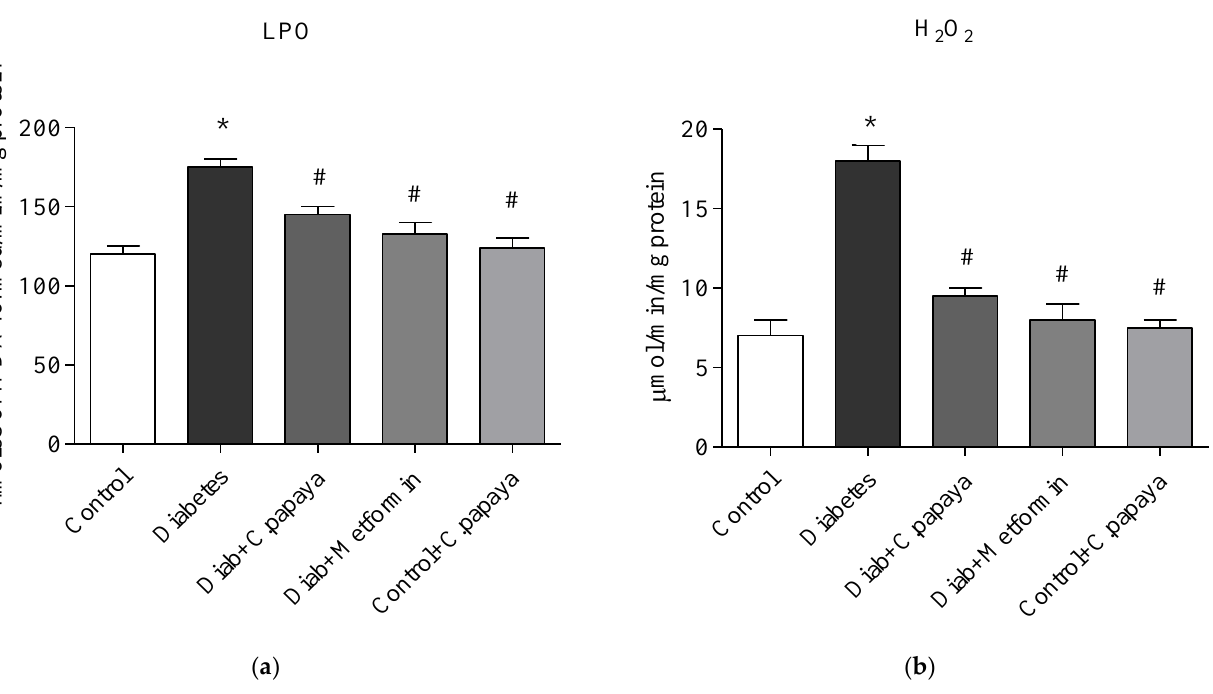
Figure 6. Role of C. papaya on ( a ) LPO and ( b ) H 2 O 2 levels. p < 0.05 was considered statistically significant among the groups: *-control;